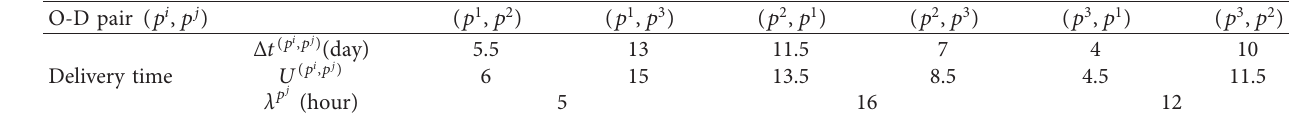
Table 2: Data about delivery time.